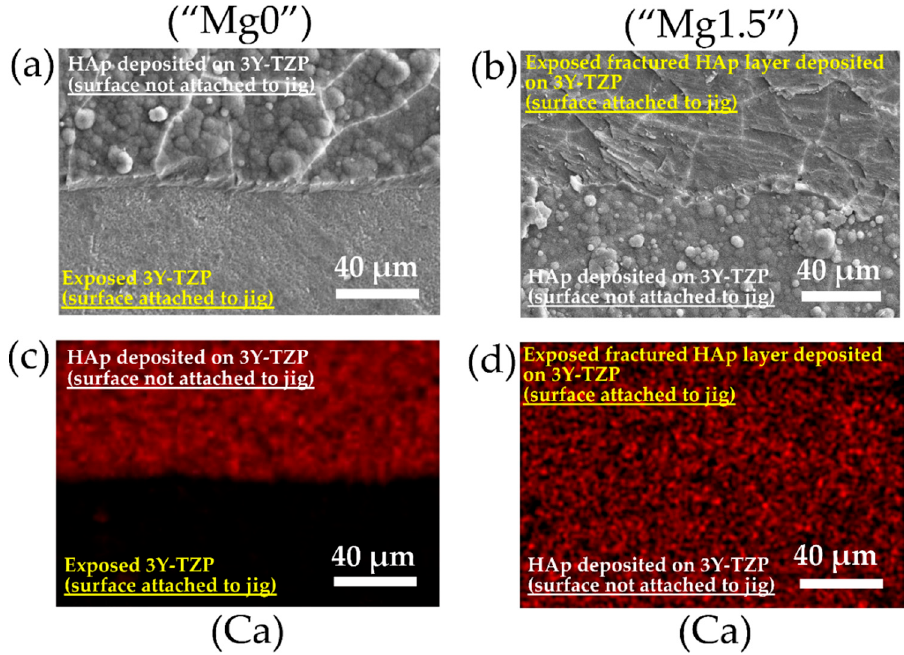
Figure 9. SEM images and EDX elemental mapping images of the surface of ( a , c ) “Mg0” and ( b , d ) “Mg1.5” solution treated HF-etched 3Y-TZP samples after the adhesive strength test.